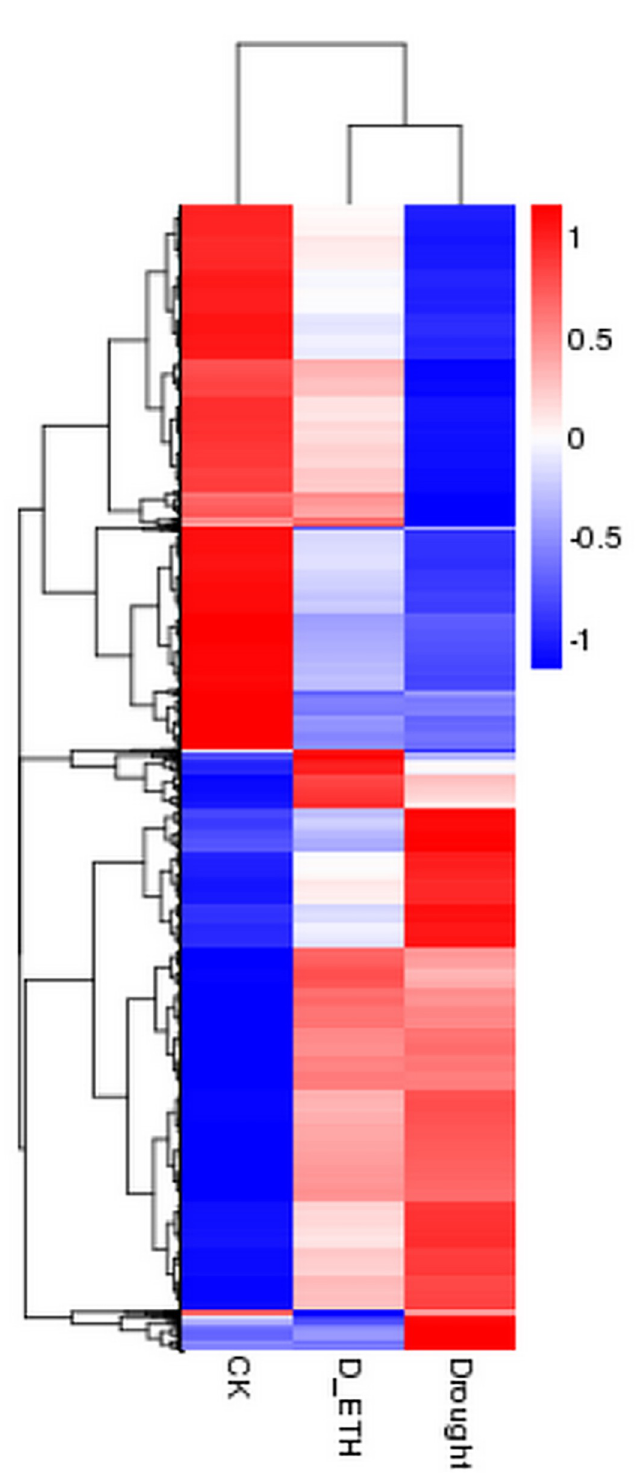
Fig 6. Heat map of all differentially expressed genes in Kentucky bluegrass. ‘CK’ means well-watered control plants without ethephon pre-treatment. ‘Drought’ means drought-stressed plants without ethephon application. ‘ETH_D’ means drought-stressed plants with ethephon